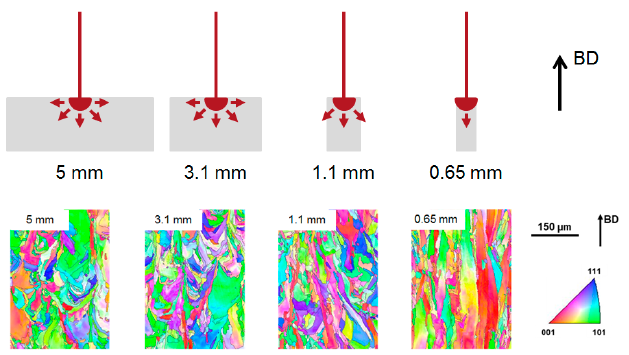
Figure 11. Schematic highlighting the interrelations of meltpool size, heat flux, and resulting microstructure for geometries being characterised by miniaturised dimensions. Interrelations hold true for materials not showing any phase transformation upon solidification, partly recompiled from [38].